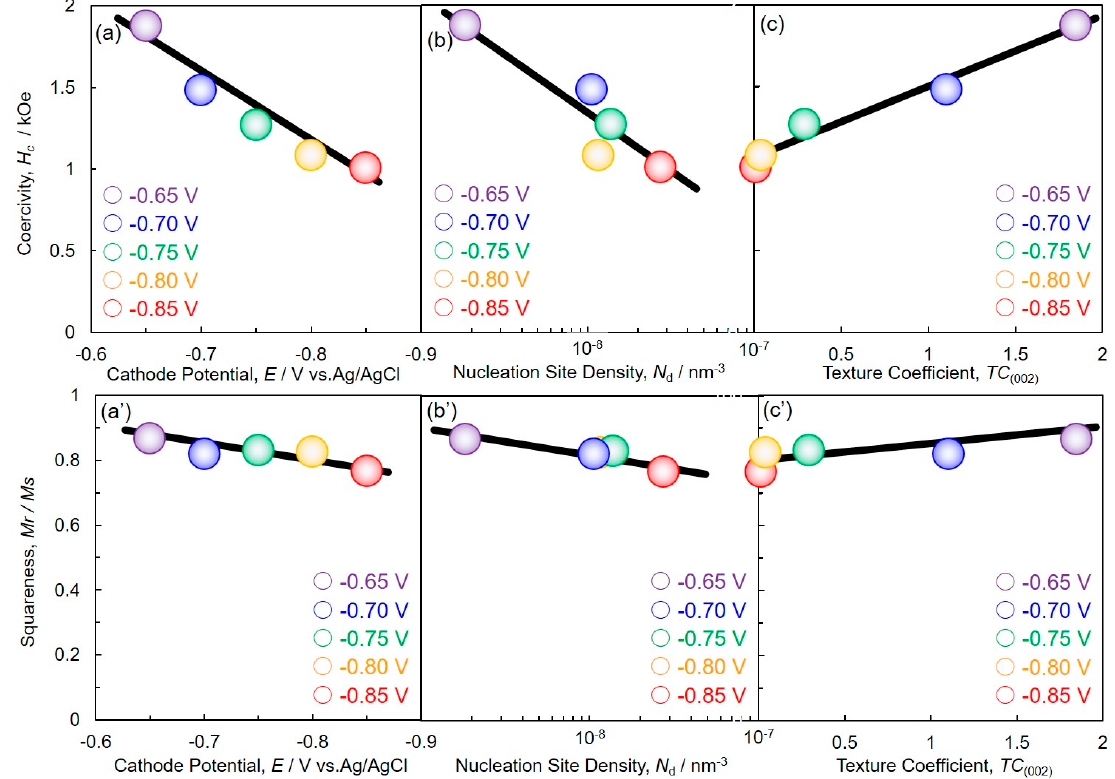
Figure 11. Effects of the cathode potential, nucleation site density and texture coefficient on the coercivity and squareness of electrodeposited Co nanowire arrays. Magnetic field was applied to the perpendicular direction with respect to the films.